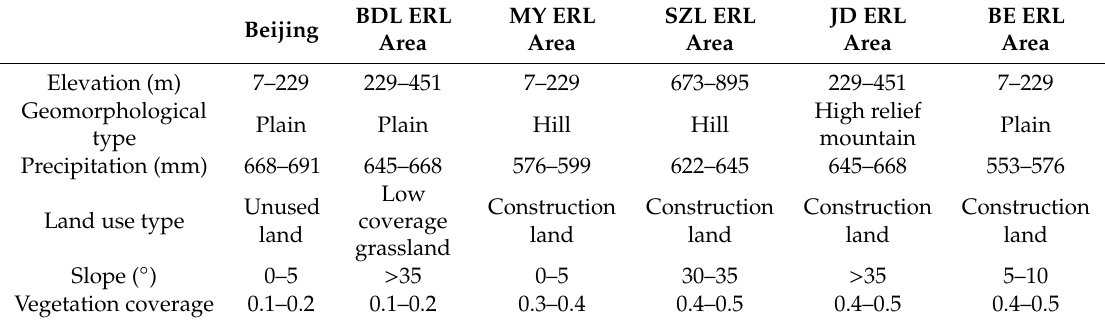
Table 7. High water yield areas in water retention ERL